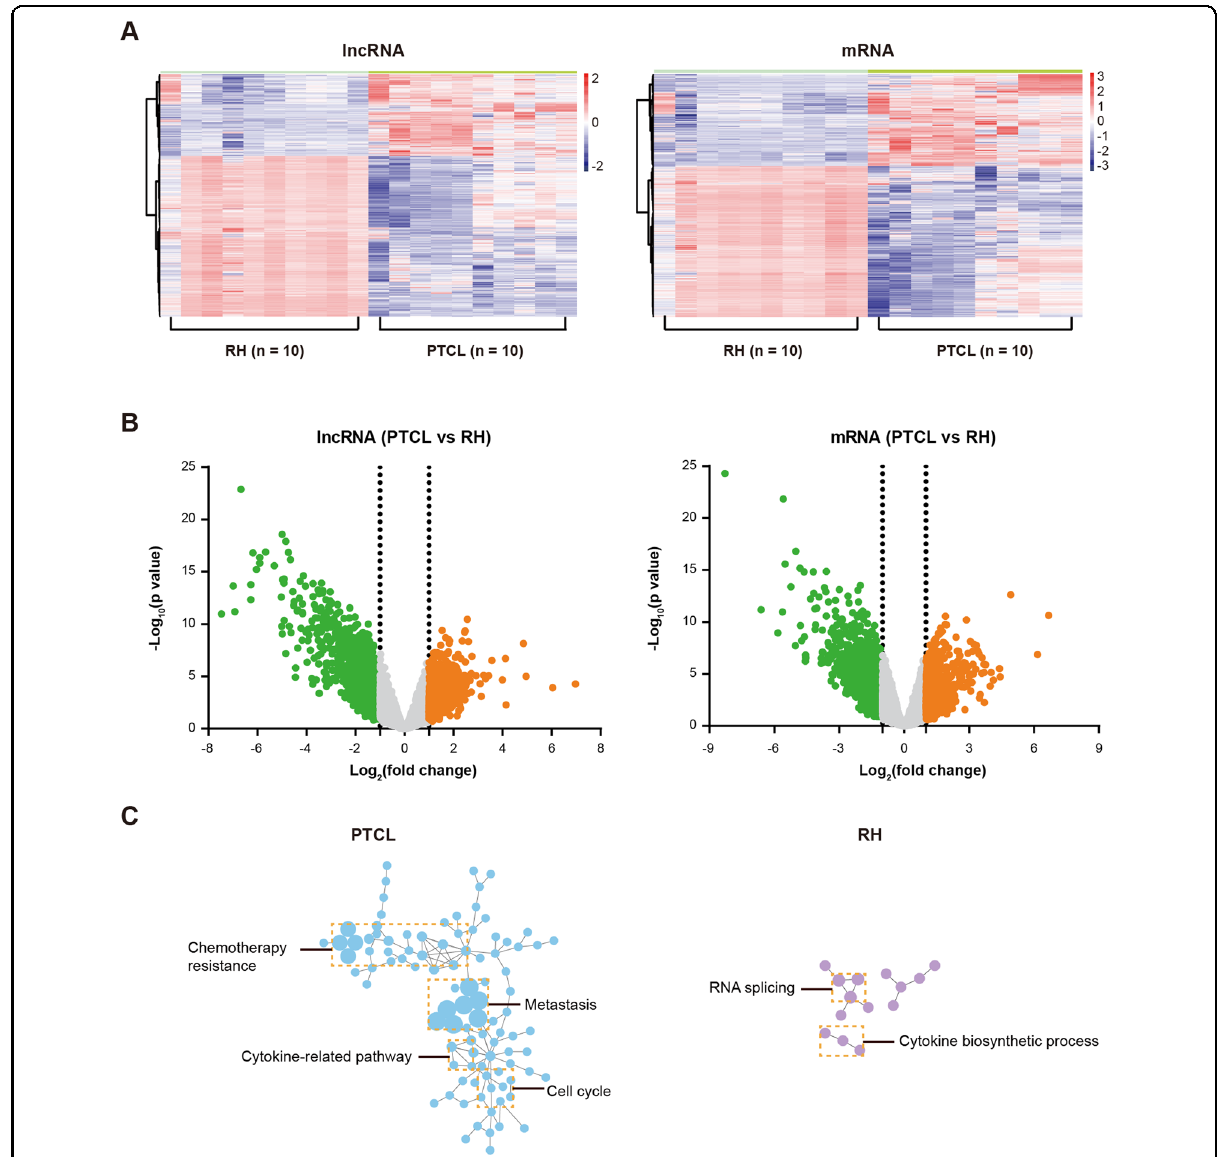
Fig. 1 ENST00000503502 was overexpressed and related to oncogenes in peripheral T cell lymphoma (PTCL). A LncRNA and mRNA expression in reactive hyperplasia (RH, n = 10) and peripheral T cell lymphoma (PTCL, n = 10) as revealed by lncRNA and mRNA microarray. B Volcano plot images of differentially expressed genes in PTCL and RH. C The gene signatures of ENST00000503502-coexpressed mRNAs in PTCL and